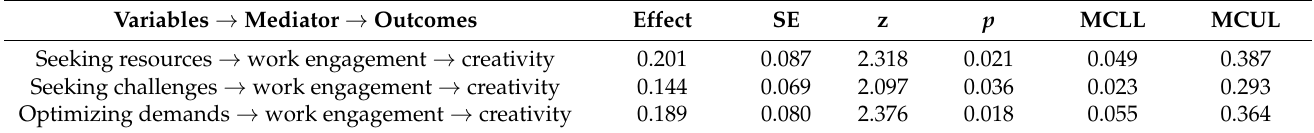
N = 176; unstandardized regression coefficients are reported; bootstrap sample size = 5000 bias corrected; LL = lower limit, UL = upper limit; significance level of confidence is at